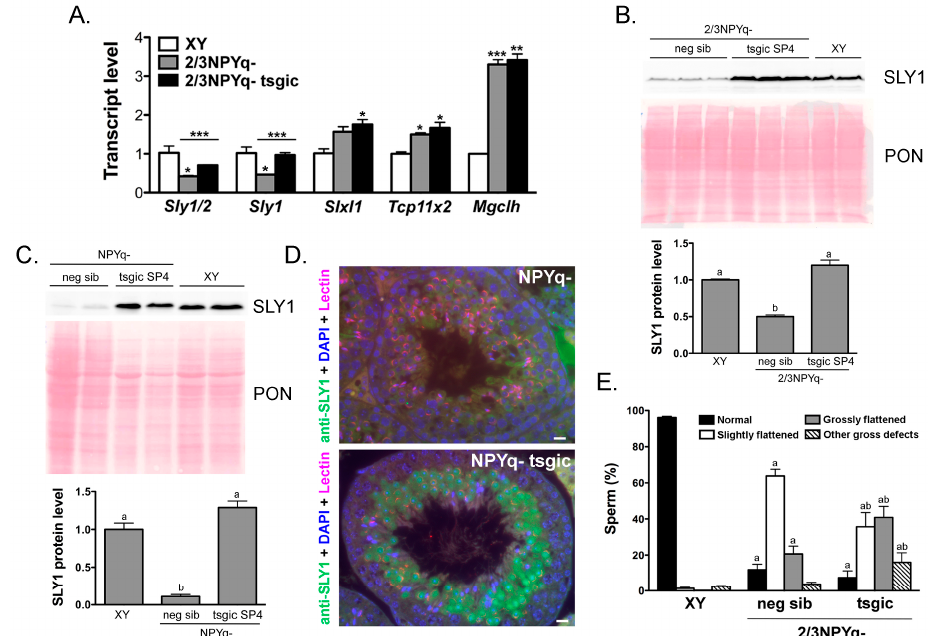
Figure 6. Flag- Sly1 SP4 transgenic line generated and analyzed independently confirms that the rescue of Sly1 expression does not lead to the rescue of the spermiogenic phenotype of mice with NPYq deficiency. ( A ) Gene expression in testes from NPYq-deficient mice without (2/3NPYq-) and with (2/3NPYq- tsgic) the Flag - Sly1 SP4 transgene was obtained by real-time RT-PCR with Acrv1 as a loading control and normalized to wild-type XY controls. The graphs are mean ± SEM with n = 3. Statistical significance ( t -test): * < 0.05; *** < 0.001, in comparison with NPYq-deficient mice with XY; the difference between transgenics and their negative siblings is marked with a horizontal lane above the relevant graph pairs. Primer sequences are shown in Table S2. ( B , C ) SLY1 expression rescue shown with Western blot performed with whole testes lysates obtained from males with moderate NPYq deficiency (2/3NPYq-) ( B ) or from males lacking the entire Y chromosome long arm (NPYq-) ( C ) with (tsgic SP4) and without (neg sib) the addition of the Flag - Sly1 SP4 transgene. Levels of protein expression were quantified with ImageJ software and normalized to Ponceau (PON) signal. The data represent an average ± SDev, with n = 2–3. Statistical significance ( t -test, p < 0.05): bars marked with different letters are significantly different. D: Immunofluorescence detection of transgenic SLY1 protein (green) on stage VII testicular tubules from mice lacking the entire Y chromosome long arm without (NPYq-) and with (NPYq- tsgic) the Flag - Sly1 SP4 transgene. Lectin (red) was used to stage the tubules and DAPI (blue) was used to stain the nuclei. Bar = 10 µ m. ( E ) Sperm headshape analysis performed for NPYq-deficient mice without (2/3NPYq-) and with (2/3NPYq- tsgic) the Flag - Sly1 SP4 transgene, and XY controls. Normal headshape and three categories of headshape defects were differentiated and quantified. The data represent an average ± SEM with n = 13, 8, and 3 males of the XY, 2/3NPYq-, and 2/3NPYq- tsgic genotype; a total of 1227, 651, and 274 sperm were examined for XY, 2/3NPYq-, and 2/3NPYq- tsgic genotype, respectively. Statistical significance: two-way ANOVA with genotype and sperm headshape as factors revealed a significant effect of genotype ( p = 0.0034), headshape ( p < 0.0001) and interaction ( p < 0.0001). The results of paired comparison for specific sperm headshape between transgenic and negative siblings in post-hoc Bonferroni test are shown within graphs: a p < 0.05 when compared to XY and b p < 0.05 when compared to